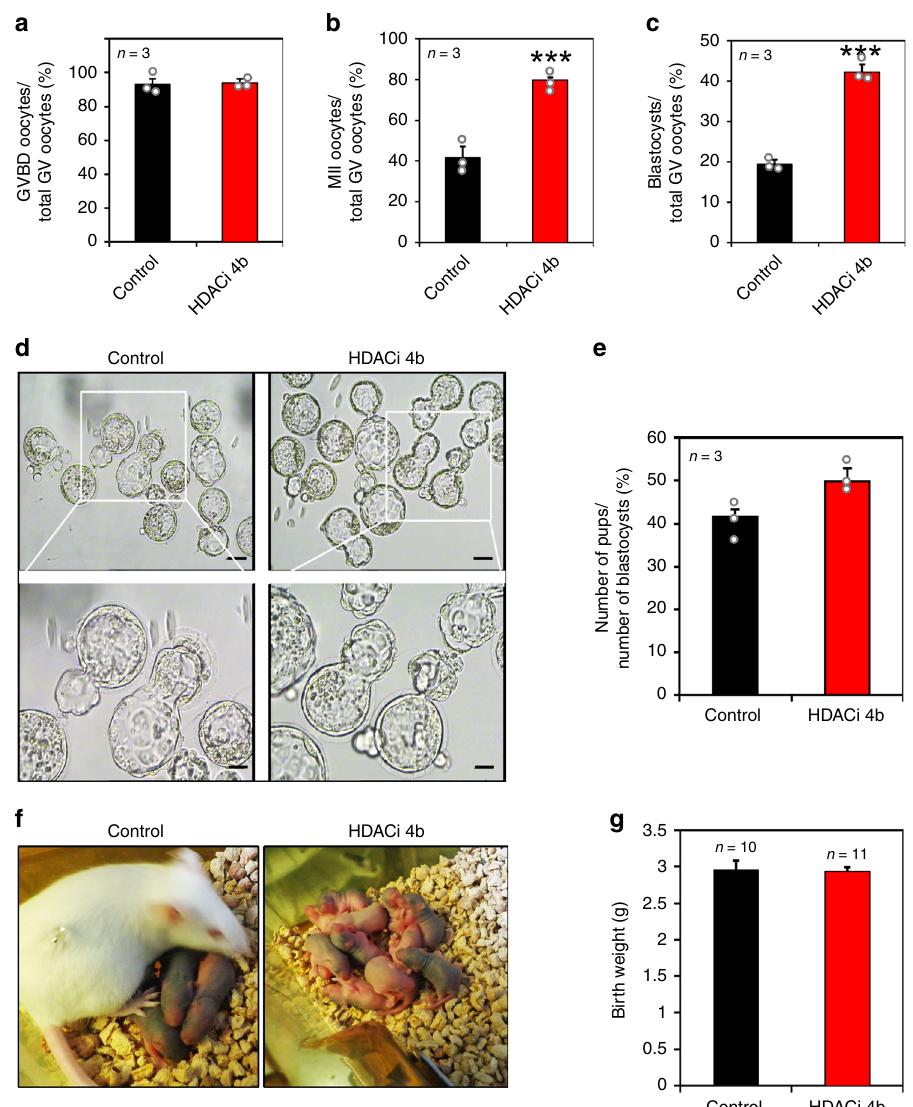
Fig. 6 The HDAC3 inhibitor improved mouse oocyte maturation and developmental competence. a The GVBD ratios were similar in the control and HDACi 4b groups. HDACi 4b, HDAC3 inhibitor. b More MII-stage oocytes were present in the HDACi 4b group than in the control group. Data are presented as mean ± SEM. Asterisks (*) indicate signi fi cant differences at *** P = 0.0002 determined by the two-sided t test. c The blastocyst rate of all GV stage oocytes was considerably increased in the HDACi 4b group compared with the control group. Data are presented as mean ± SEM. Asterisks (*) indicate signi fi cant differences at *** P = 0.0006 determined by the two-sided t test. d Representative images show blastocysts obtained from the control and HDACi 4b groups. Scale bars = 100 µ m and 40 µ m (enlarged). n = 3 biologically independent experiments. e , f Blastocysts from the control and HDACi 4b groups were transferred into surrogate mice. e Birth rates of the control and HDACi 4b groups. f Representative images depicting the pups born in the control and HDACi 4b groups. g The birth weights of the pups in the control and HDACi 4b groups were similar. The data are presented as the mean ± SEM. Source data are provided as a Source Data fi